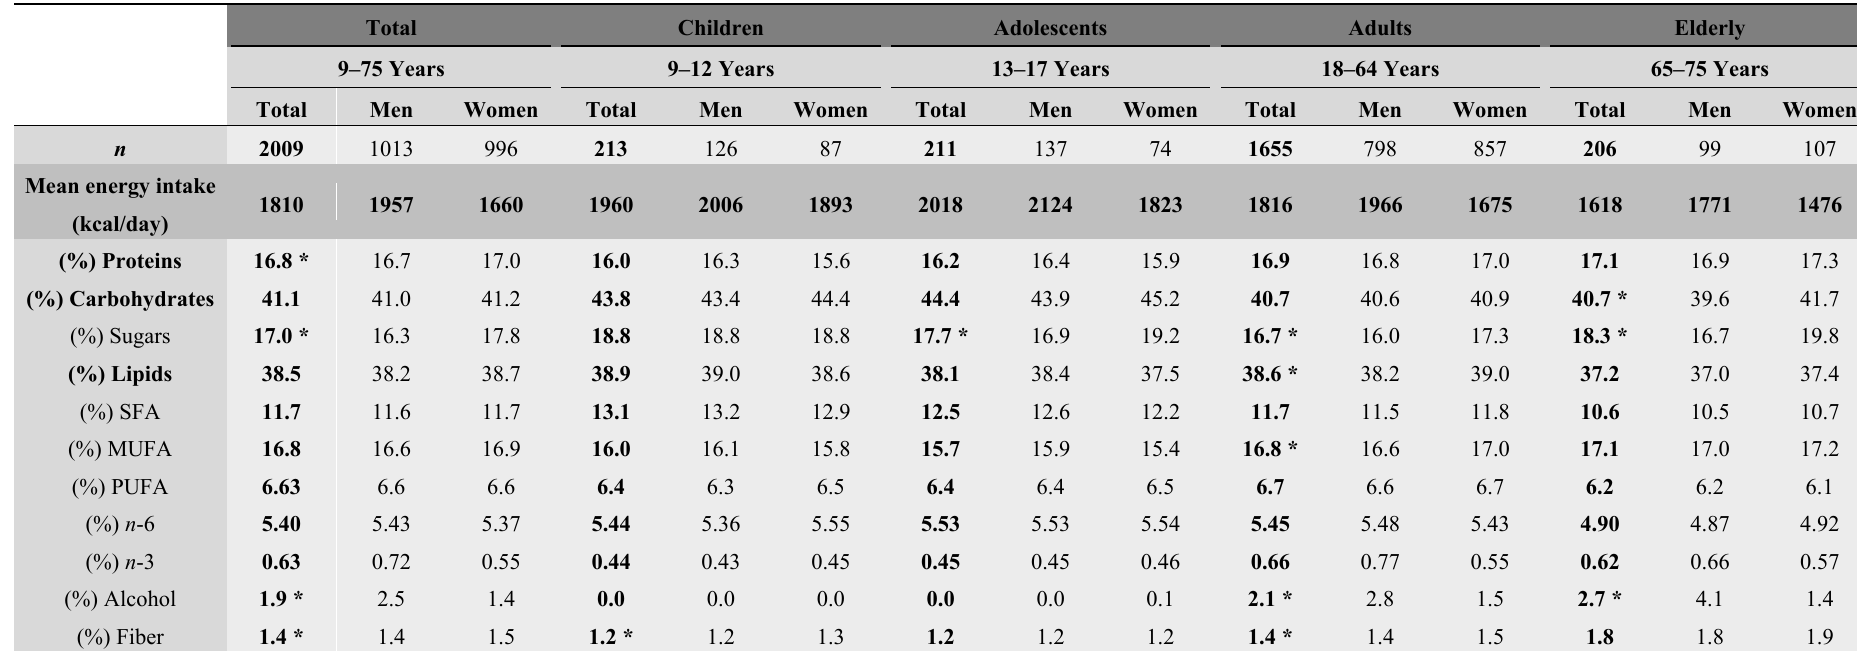
Table 3. Energy and lipid profile (%) in the ANIBES survey of the Spanish population aged 9–75 years, by sex and age group. Total Children Adolescents Adults